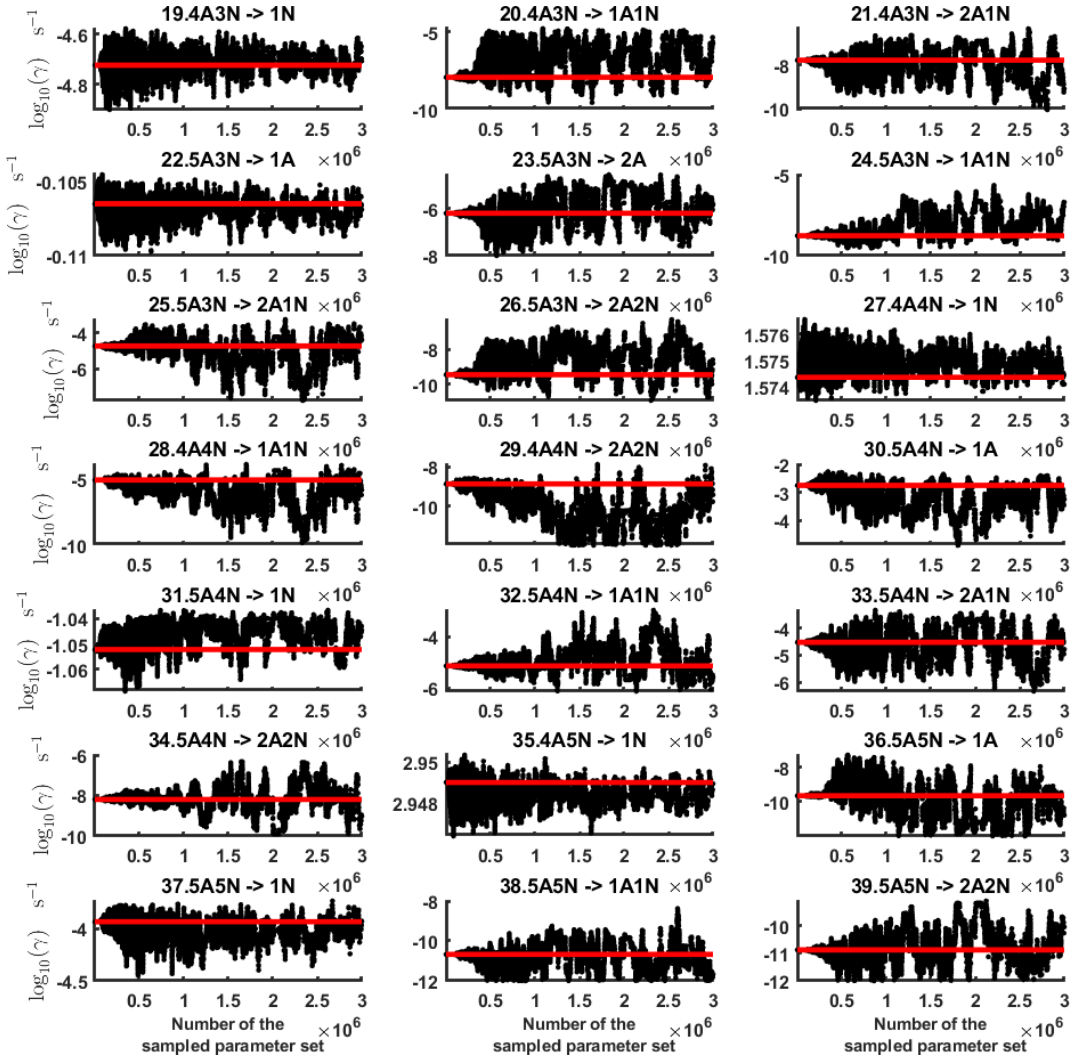
Figure C3. Parameter chains (for parameter indexes ranging from 29 to 39) of the base 10 logarithm of the evaporation rates (units given in s − 1 ) determined from time-dependent measurements of the cluster concentrations with time resolution comprising 1.5min at the temperature 278K. Red lines denote the baseline values from Olenius et al. (2013b) used to generate the synthetic data. The notation xAyN corresponds to a cluster with x sulfuric acid and y ammonia